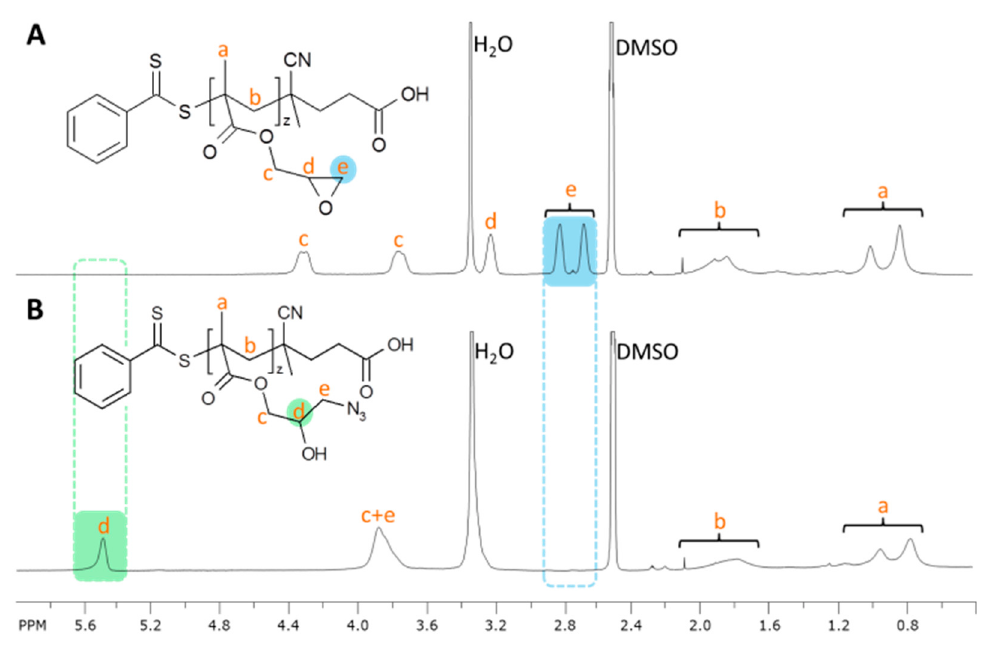
Figure 3. 1 H-NMR spectra in DMSO- d 6 of ( A ) PGMA and ( B ) P(GMA-N 3 ).